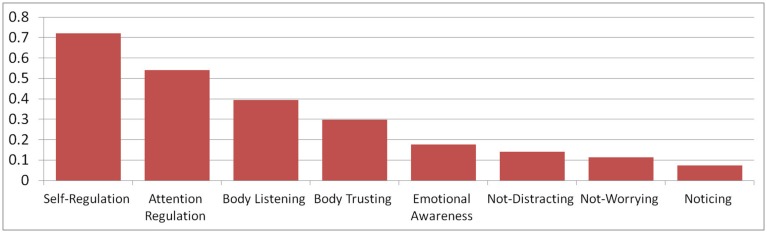
Effect sizes for changes in the intervention group relative to the control group. Note: Effect sizes are computed as d = (M_TrainT1-M_TrainT0)/[(1/2)(SD_TrainT0+SD_TrainT1)] – (M_ControlT1-M_ControlT0)/[(1/2)(SD_ControlT0+SD_ControlT1)], that is, the mean differences in the training group, standardized by their standard deviation, minus the same measure in the control group (cf. Cohen, 1988).